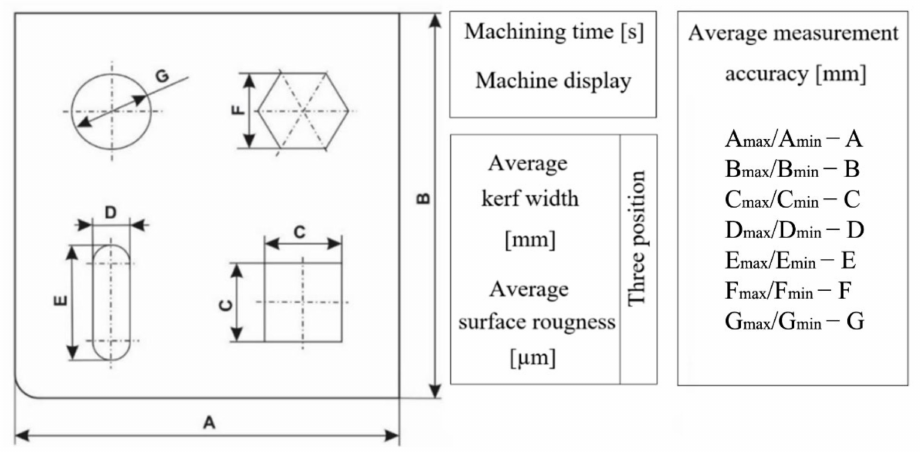
Figure 4. Methodology for measurement of various machining performances.